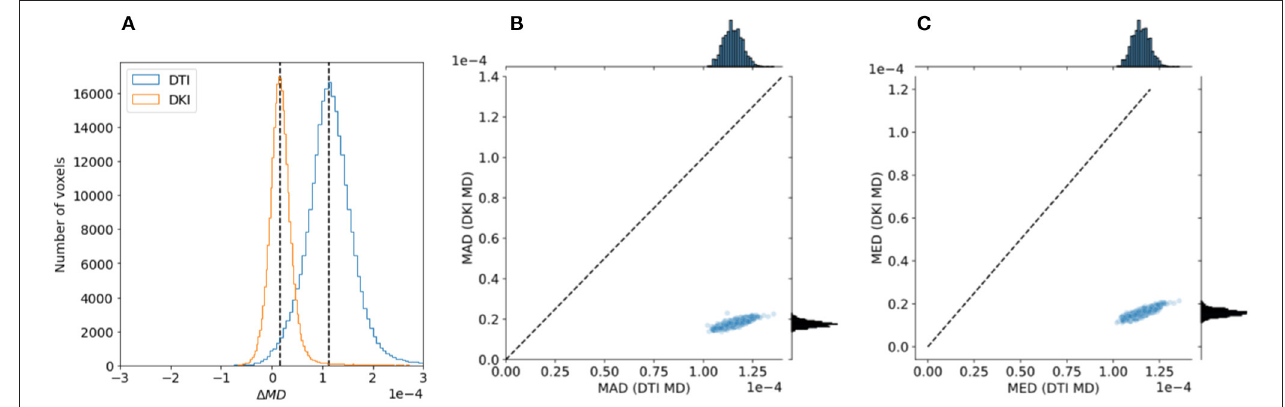
FIGURE 10 | Comparing DTI And DKI MD variability in the Human Connectome Project dataset. A similar analysis to Figure 9 was conducted with MD, comparing two partially overlapping subsets of data to each other. Here as well, we find that within an individual example subject (A) , as well as in the entire sample, both the mean absolute deviation (B) and median value (C) are higher for DTI than for